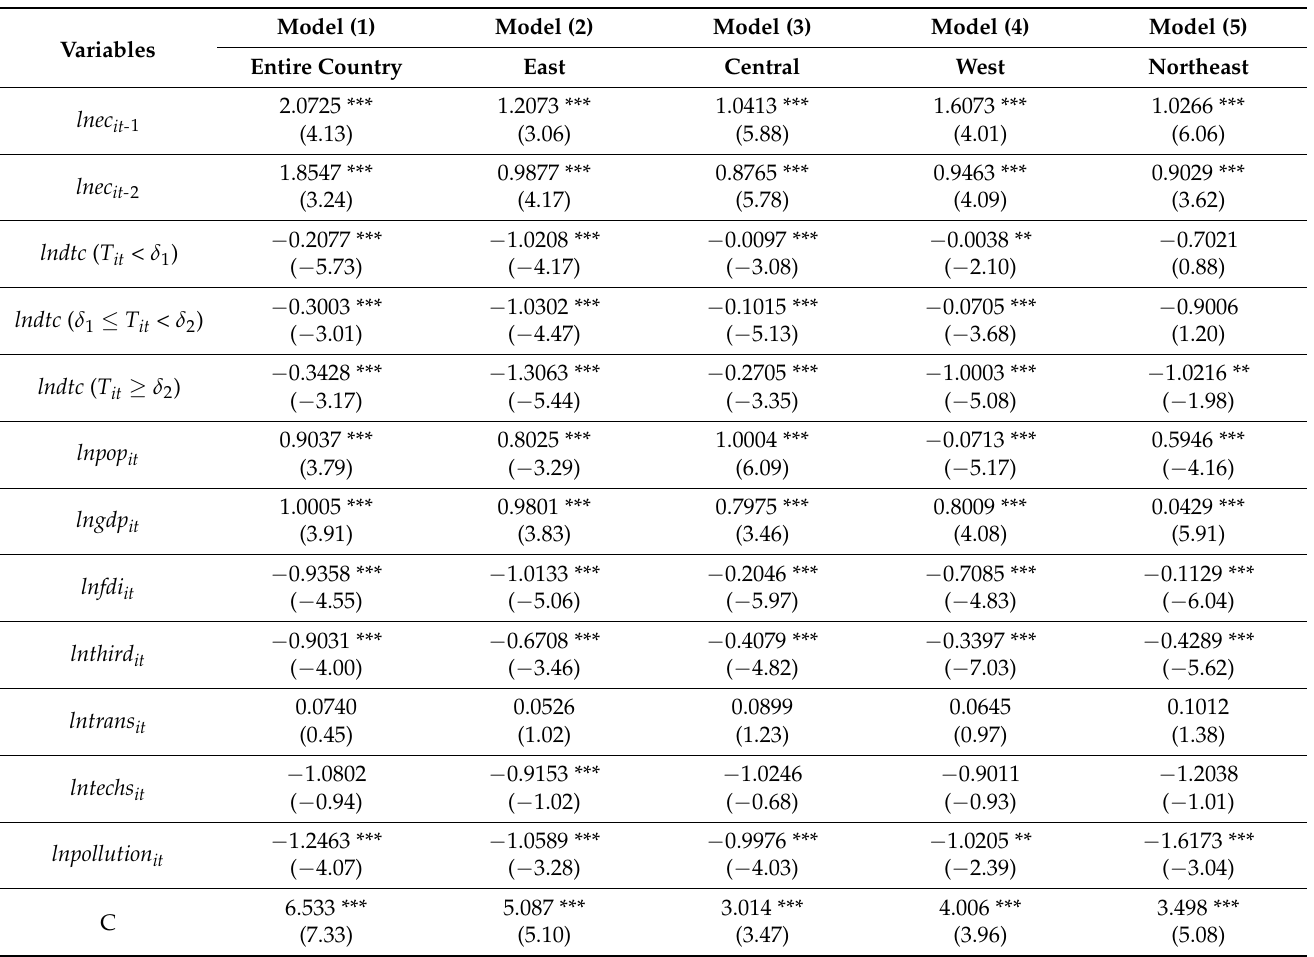
Table 4. Dynamic threshold regression results of capital-saving technical change on carbon footprint in different